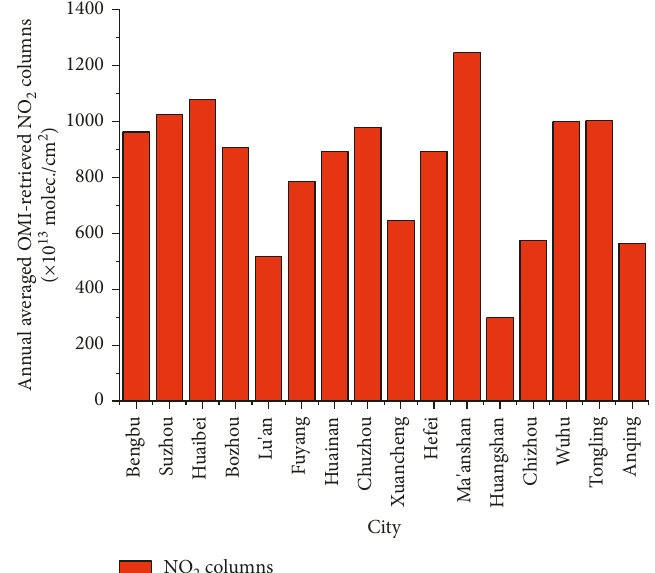
13 molec./cm 2 ) from 2005 to 2016 of cities in Anhui Province. 2 columns ( × 10